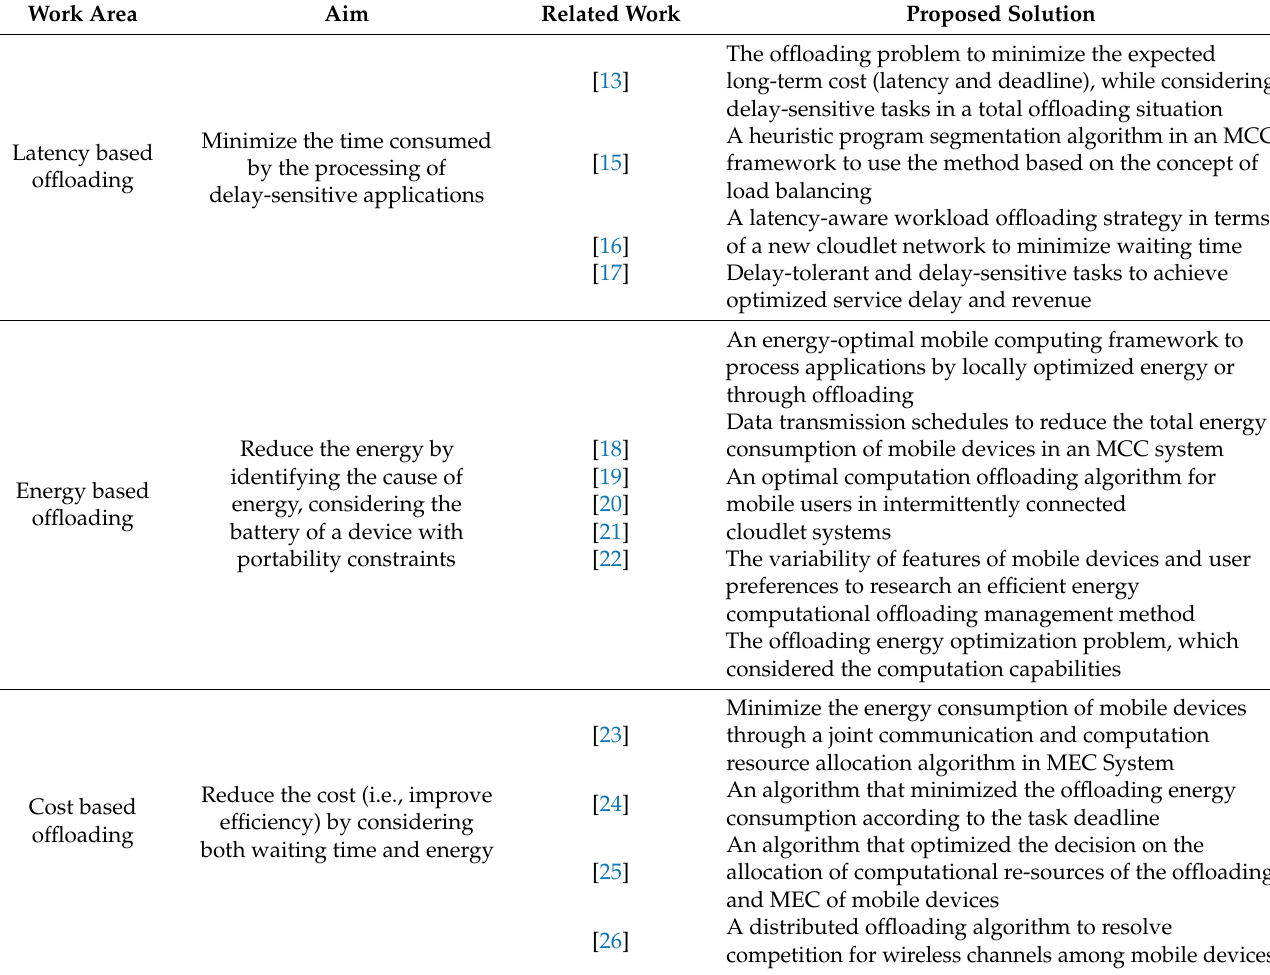
Table A1. Summary of literatures on computation